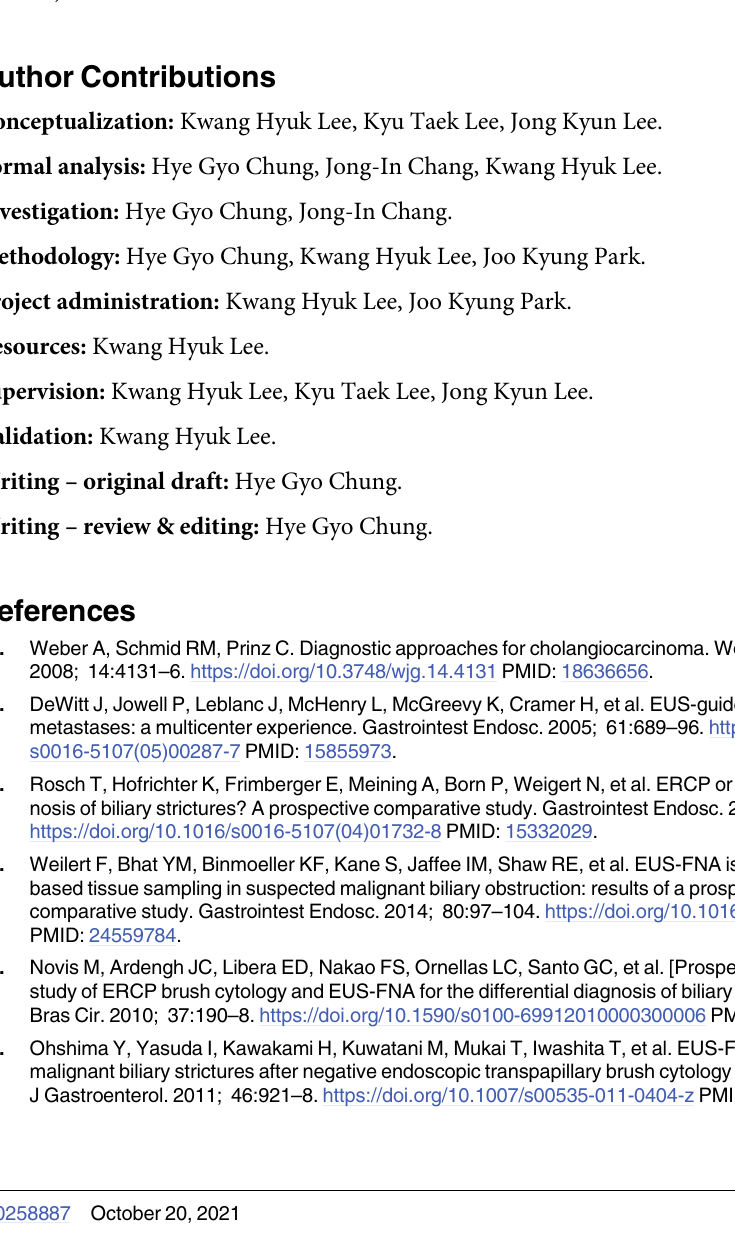
S1 Table. Needle types used for EUS-FNA/B. S2 Table. Detailed clinical managements after the pathology/cytology results of ERCP and